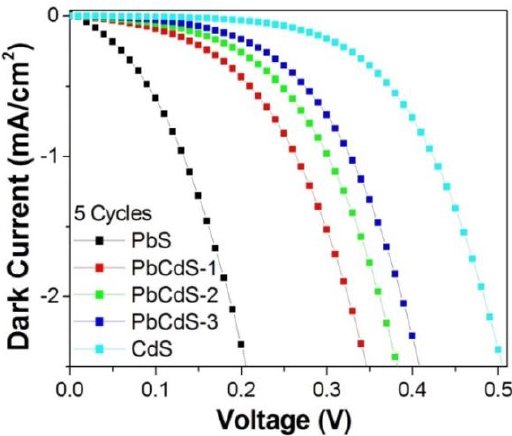
Figure 4. Dark I–V curves of QDSCs employing five-SILAR-cycle PbS, PbCdS-1, -2, -3, and CdS. The optimization of the SILAR cycles is a key factor to boost the performance of the solar cells. Herein, we discuss the effect of SILAR cycles on the photovoltaic performance of the solar cells. The I–V curves of the solar cells of PbS, CdS, and Pb x Cd 1 ´ x S under one sun illumination are depicted in Figure S2. The photovoltaic parameters are listed in Table S4. In order to analyze the effect of the SILAR cycles, the photovoltaic parameters were presented as a function of the number of such cycles as shown in Figure 5. It was observed that the performance of the PbS solar cells decreases with the increase of SILAR cycles, probably due to the narrower bandgap and the lower CB energy level of the PbS QDs when the SILAR cycles increases after three cycles. The photocurrents of the three kinds of Pb x Cd 1 ´ x S and CdS are enhanced by increasing SILAR cycles until reaching a number of certain cycles. To further optimize the performance by increasing the cycle number, it was found that 7-cycle PbCdS-1, 7-cycle PbCdS-2, 9-cycle PbCdS-3, and 9-cycle CdS QDSCs provide the best photocurrent. Moreover, the trend of the efficiency is similar to that of the photocurrent. The comparison of the parameters between the different QD solar cells indicates that the QDs with the higher proportion of Pb show the higher short-circuit current and the lower open-circuit